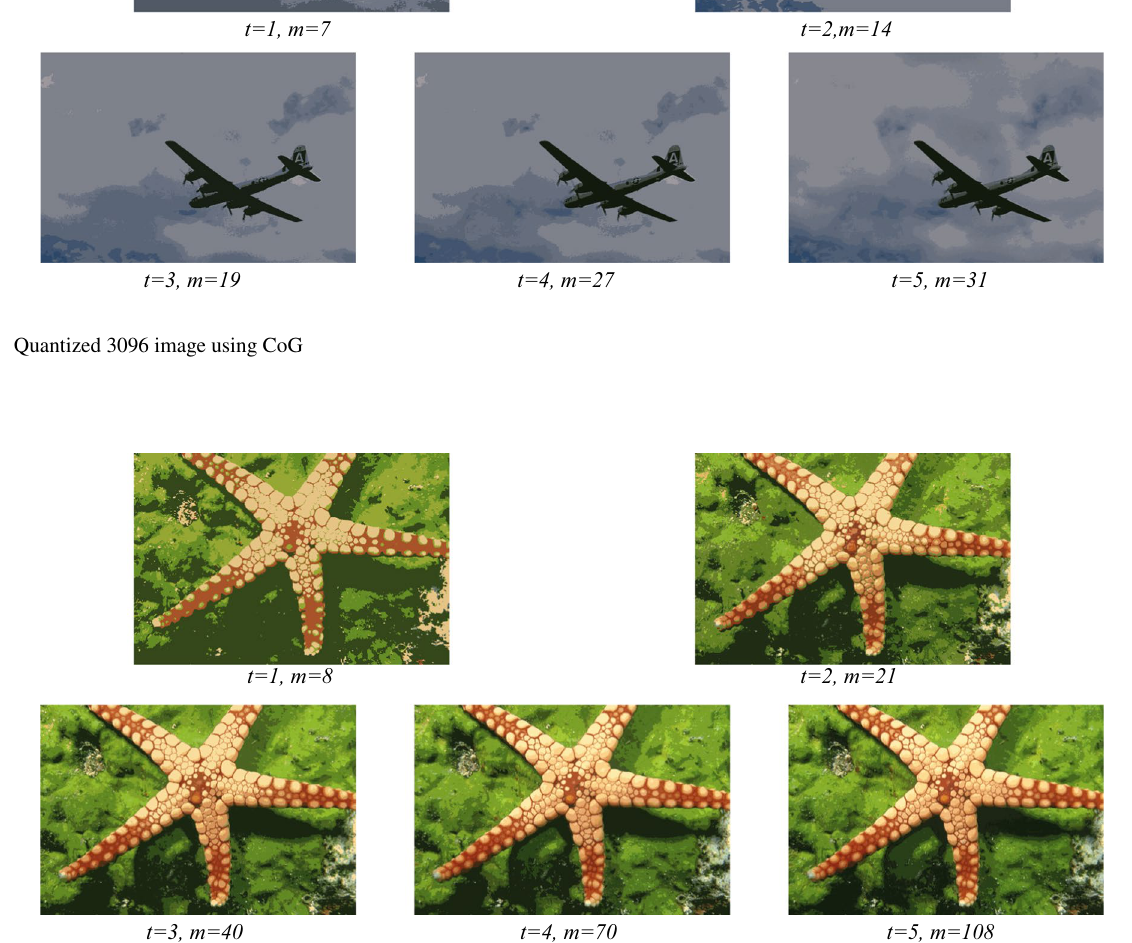
Fig. 9 Quantized 12003 image using